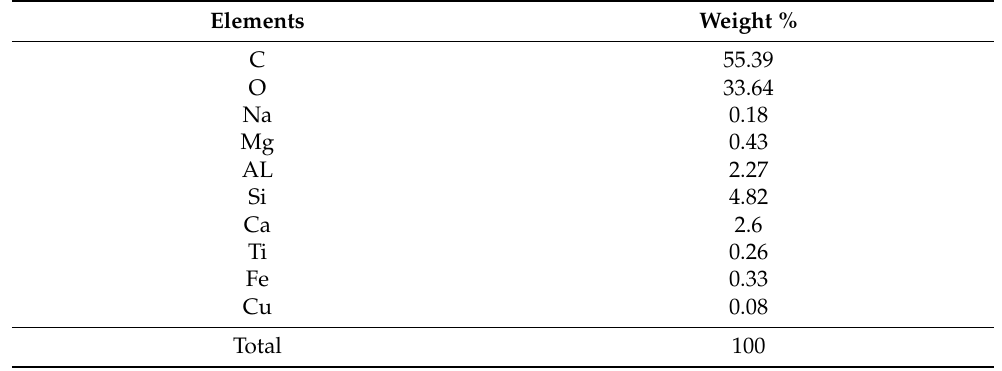
Table 10. EDS Analysis Report.